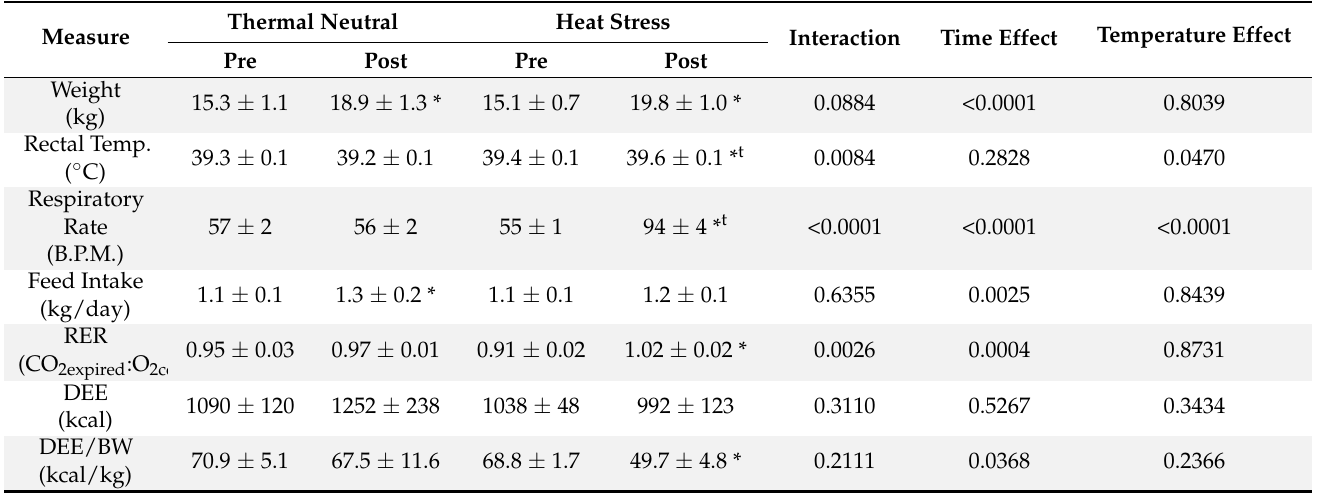
Table 1. Summary of growth, thermoregulatory, and indirect calorimetry